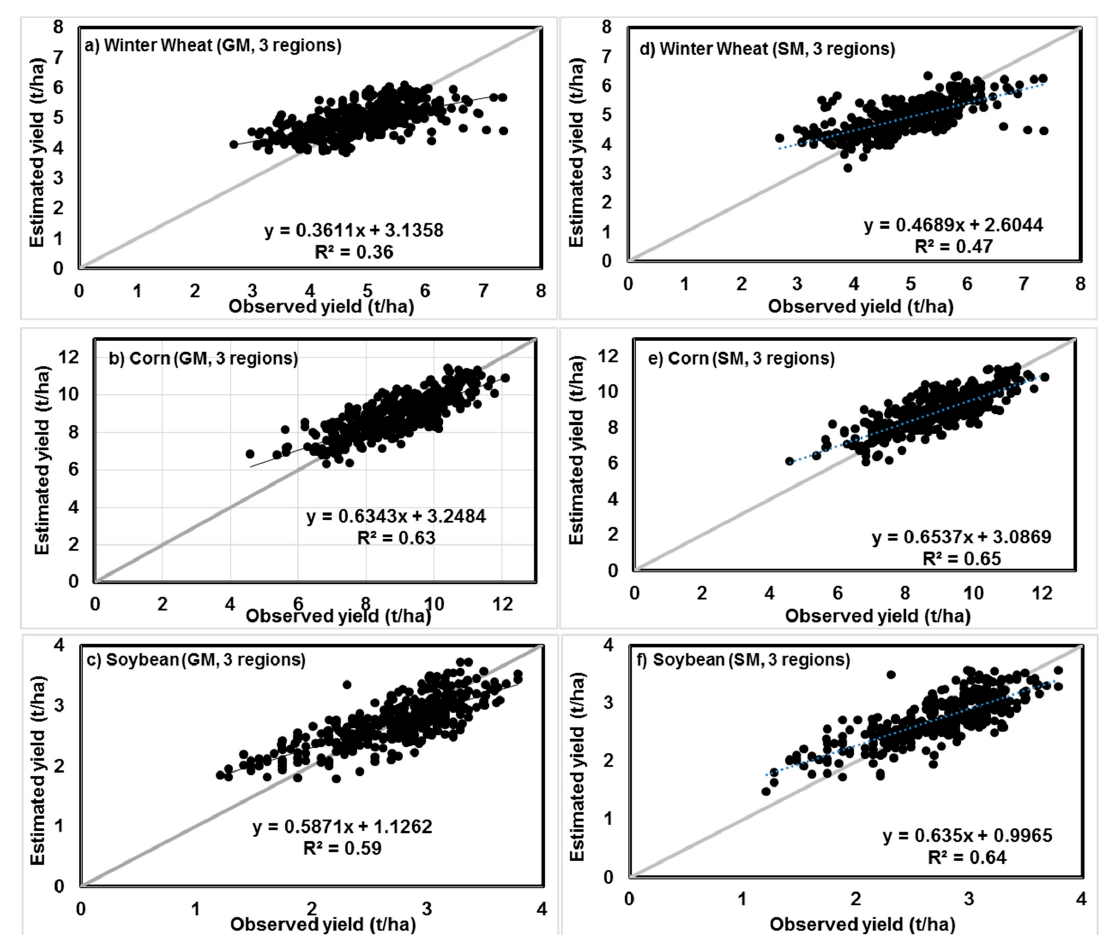
Figure 7. Relationships between reported and estimated crop yields at the county level for the period from 2003 to 2016. Crop yields were estimated using a multiple linear regression model from average EVI2 at the peak growth stages and year as independent variables. EVI2 was extracted using a general cropland mask (GM) and crop-specific masks